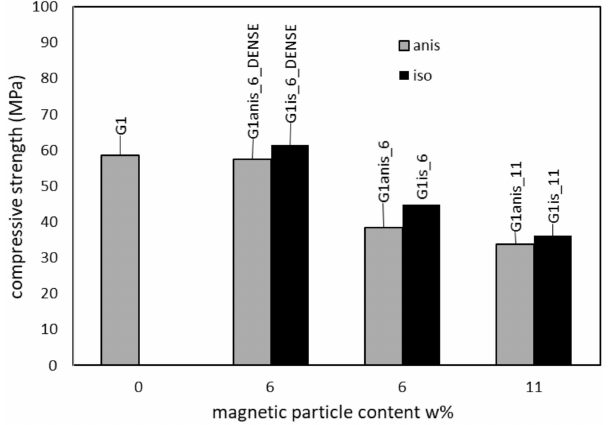
Figure 19. Compressive strength data for samples of series G1.